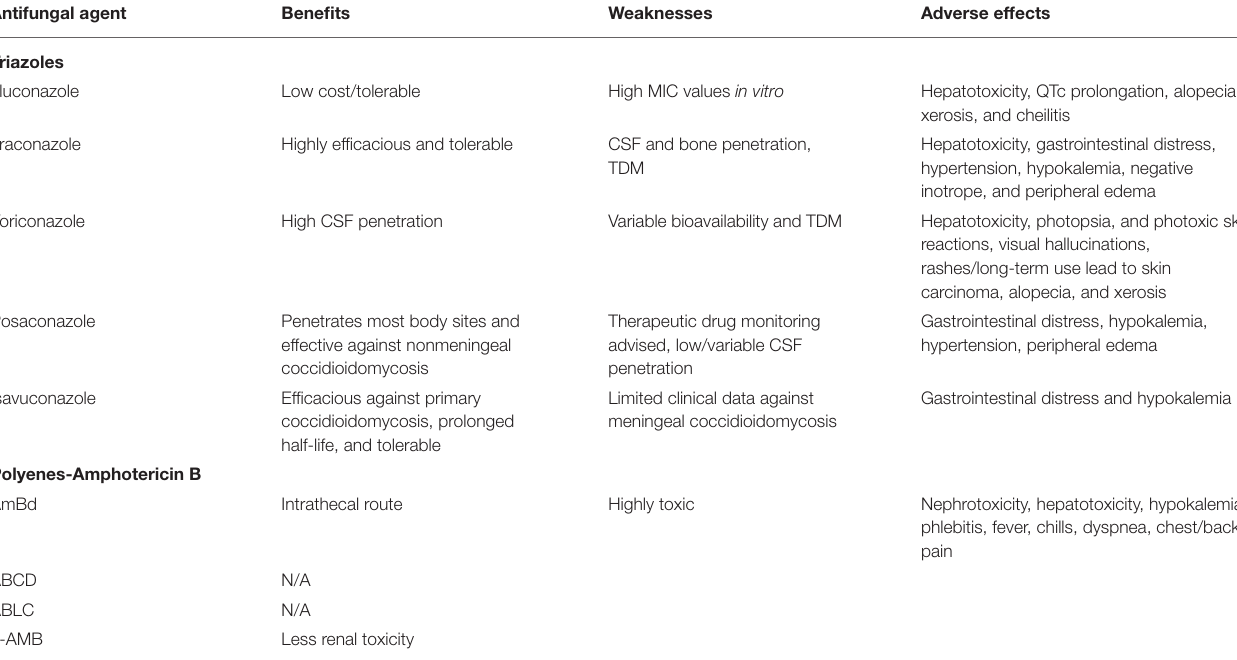
TABLE 1 | A brief overview of antifungal agents benefits, weaknesses, and adverse effects in the treatment of